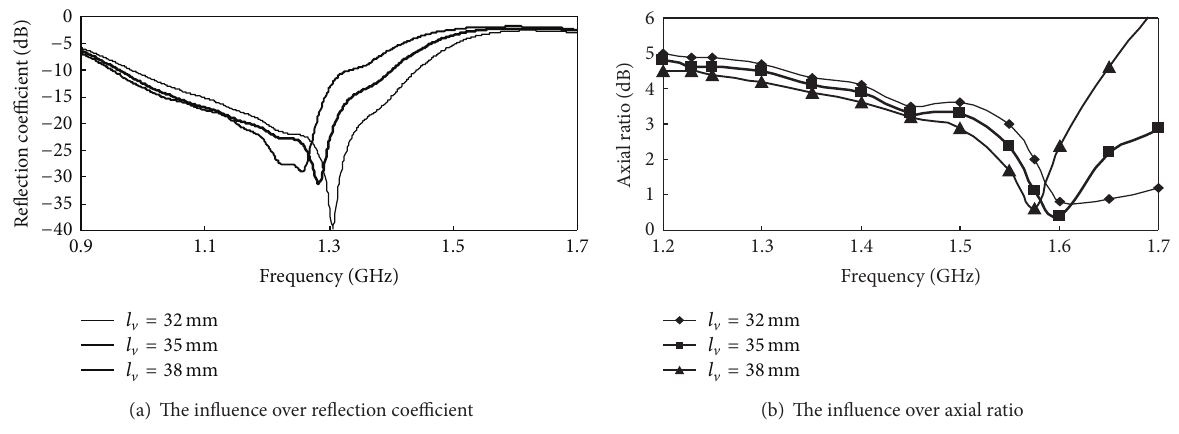
Figure 2: The influence of parameters 𝑙 V over the antenna